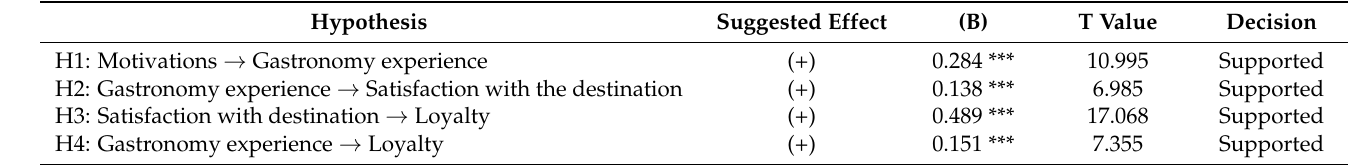
Table 4. Results of the confirmatory factor analysis (N =